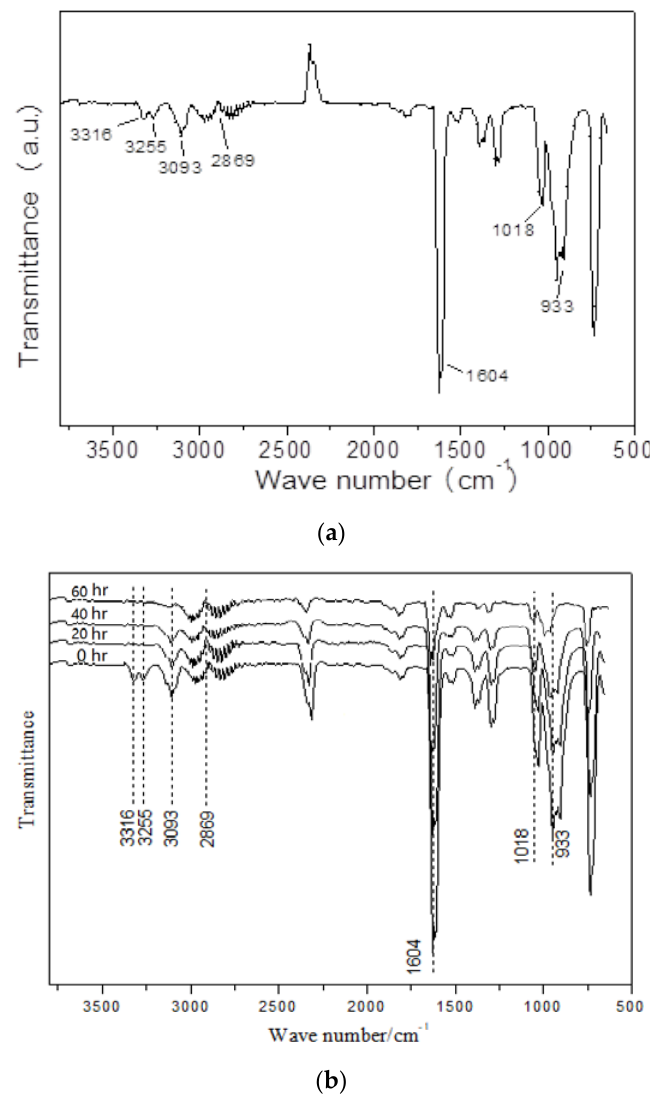
Figure 9. ( a ) FT-IR spectra of deactivated sample of SD1-Fe0.8-M; ( b ) in-situ Diffuse reflectance infrared Fourier transform spectra (DRIFTS) spectra during reactivation of SD1-Fe0.8-M treated by 10 mL min − 1 HCl at T = 220 °C and over 60 h.